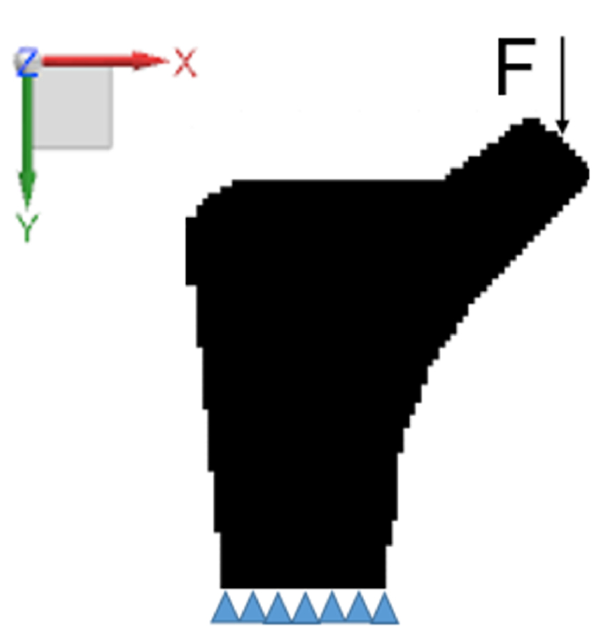
Figure 1. Structure of femoral stem.